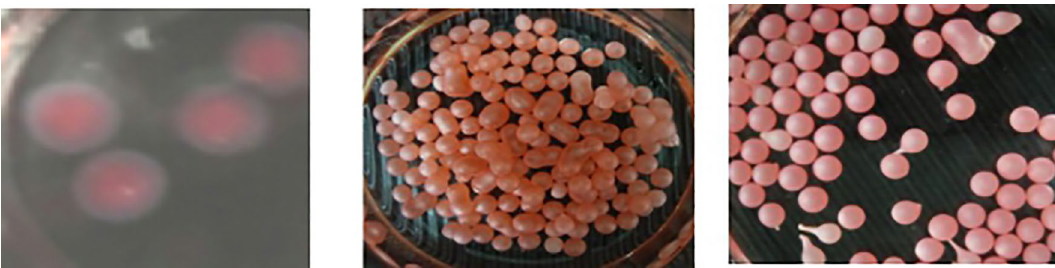
Figure 1. ( 1-1 ) Appearance of calcified microcapsules of botulinum toxin type D; ( 1-2 ) Microcapsule after alginate/protamine wrap; ( 1-3 ) Alginic